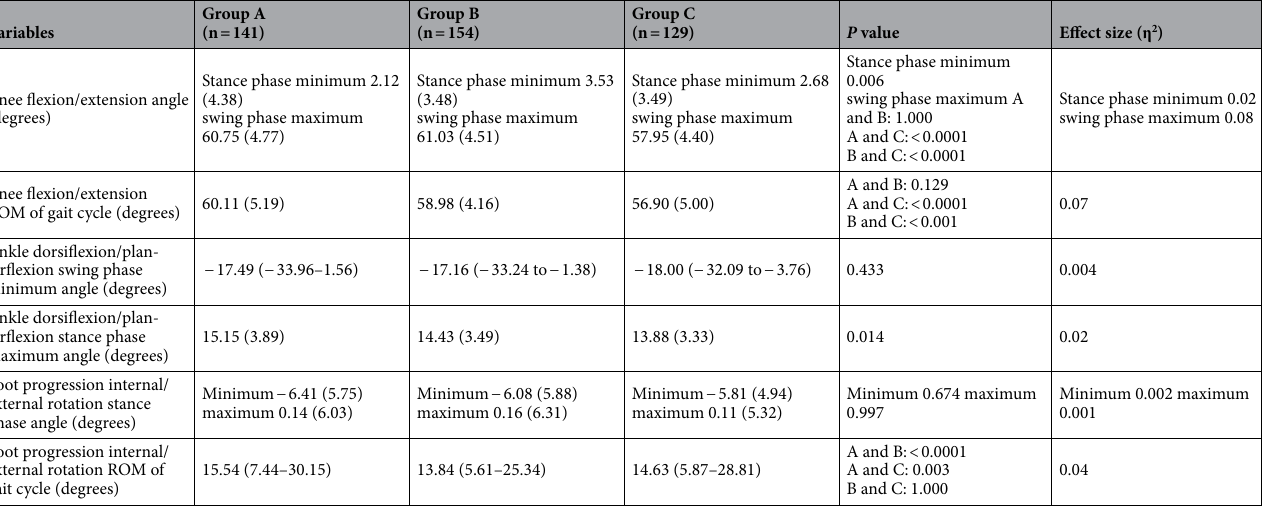
Table 5. The minimum and maximum values for the gait kinematics of the knee, ankle and foot progression angle for the three age groups (N = 424). Group A (6–8 years), Group B (9–10 years), Group C (11–12 years). Differences between the three groups were analyzed using the Kruskal–Wallis test or one-way analysis of variance. Variables with significant differences were subsequently compared using multiple comparison analyses with Bonferroni correction. Data are presented as means (standard deviation) or median values (range). P values < 0.0001 were considered statistically significant. ROM, range of motion.